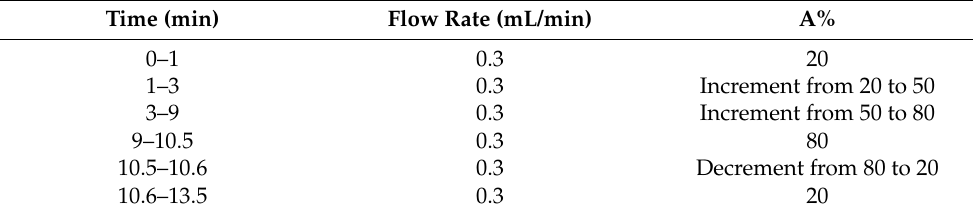
Table 1. Gradient Parameters of